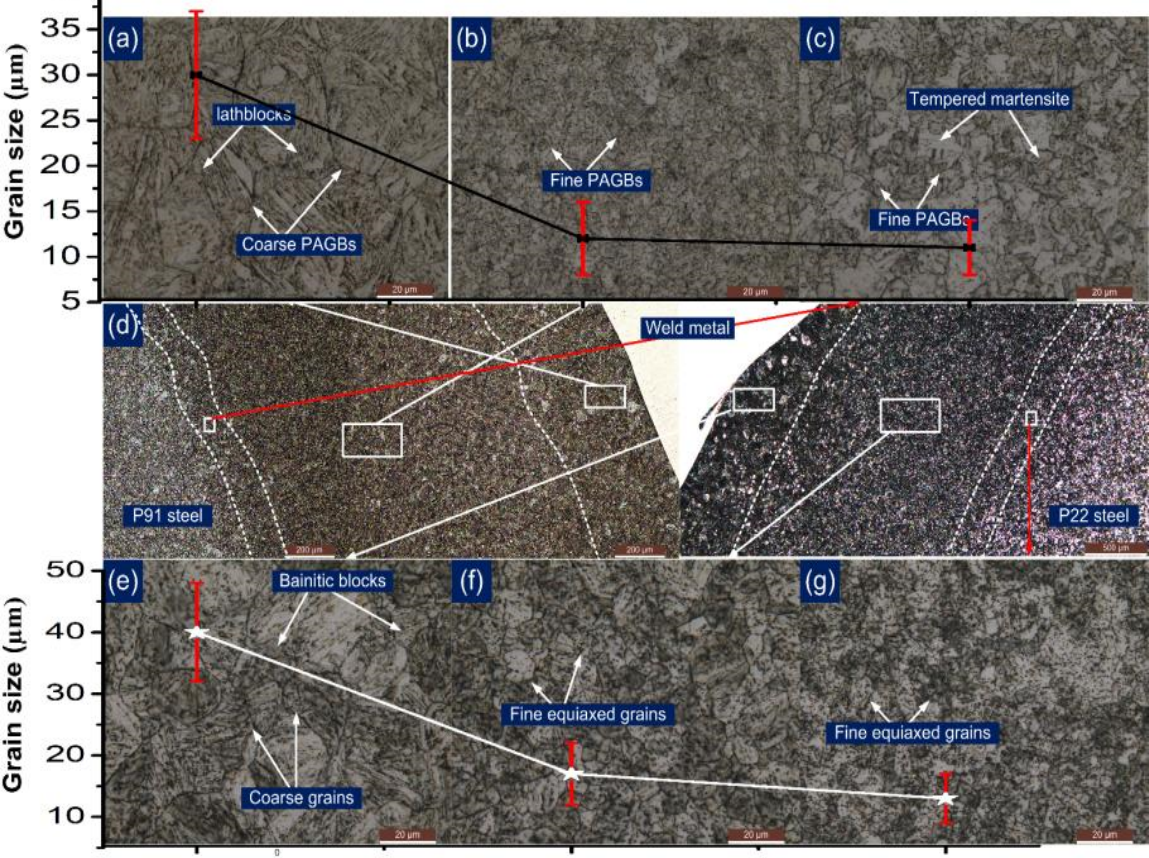
Figure 6. Inhomogeneity in microstructure along the P91 HAZ after welding: ( a ) coarse-grained HAZ, ( b ) fine-grained HAZ, ( c ) inter-critical HAZ; ( d ) optical image showing the various HAZ regions formed along P91 and P22 side; P22 HAZ region after welding: ( e ) coarse-grained HAZ, ( f ) fine-grained HAZ, ( g ) inter-critical HAZ.